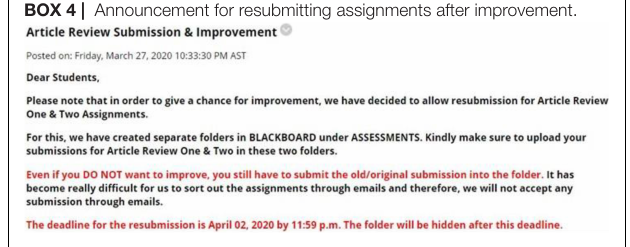
BOX 6 | Announcing online quiz timings and instructions.